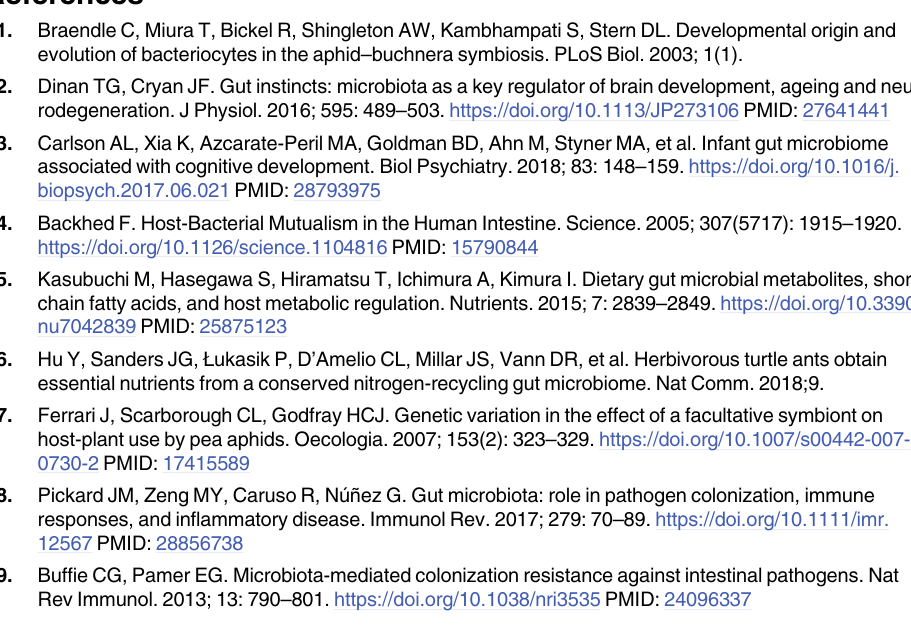
S2 Table. Pairwise PERMANOVA comparisons of bacterial communities between sample types. Bacterial communities in samples were compared in R.3.4.3 using pairwise PERMA- NOVA analysis with Bonferroni corrections. Pseudo-F values (PF) and P-values ( p ) are pro- vided. Sample types were given acronyms for simplicity: DT–Adult digestive tract, AS–Anal secretions, UC–Unprepared carcass, PC–Prepared